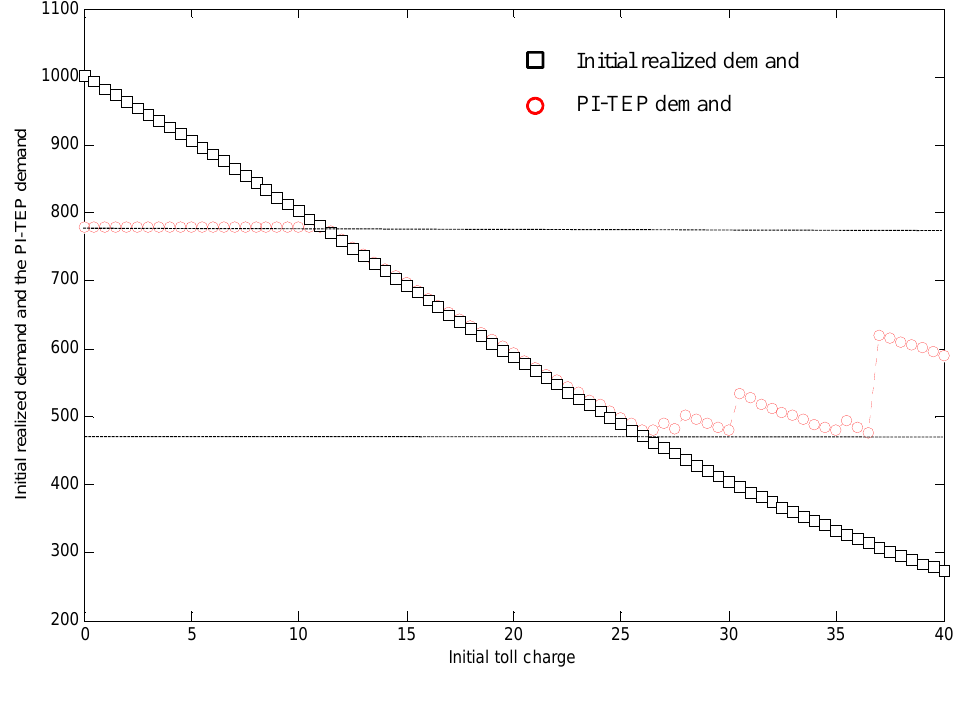
Figure 3. Realized demand before and after PI-TEP